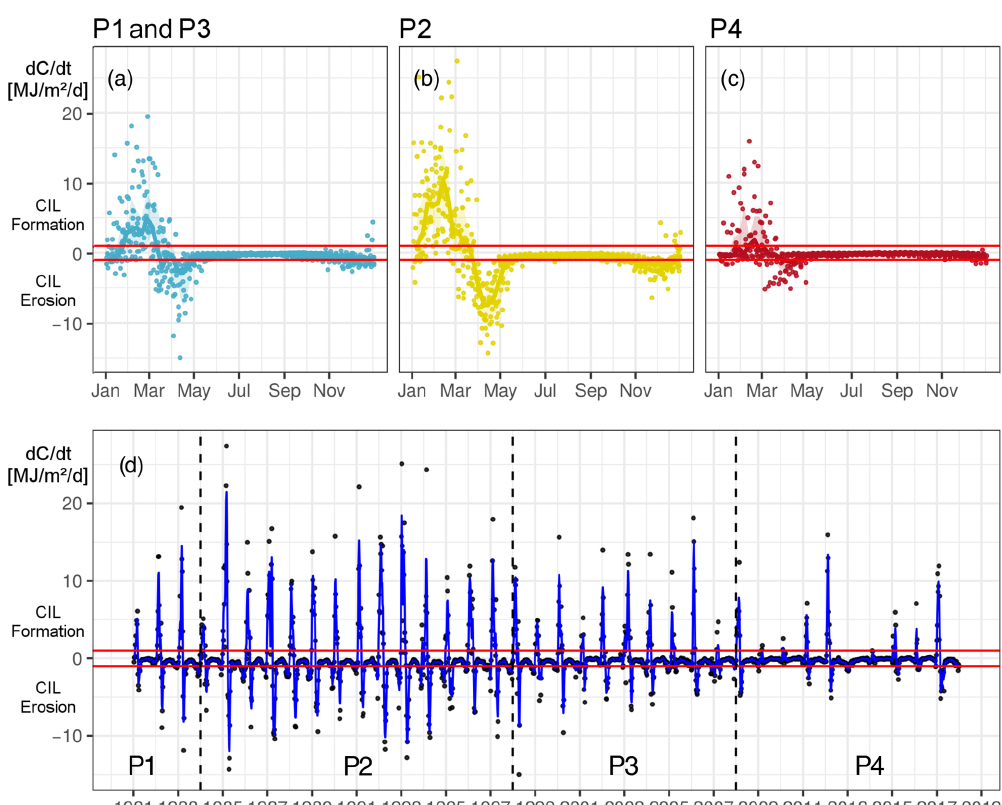
Figure 4. Weekly averaged basin-wide CIL cold-content formation and destruction rates (d C/ d t ), obtained as differences between the weekly integrated CIL cold content provided by the GHER3D model: (a–c) in a seasonal frame with weekly medians (line) and interquartile range (shaded area), merging years from the periods P1 and P3 (considered together), P2, and P4; (d) on an inter-annual scale, with a 3-week running average (blue line). Vertical dashed lines separate the four periods identified by the regime shift model. The red lines delineate the thresholds of ± 1MJm − 2 d − 1 , corresponding to the lower bound of the CIL erosion rate during summers.